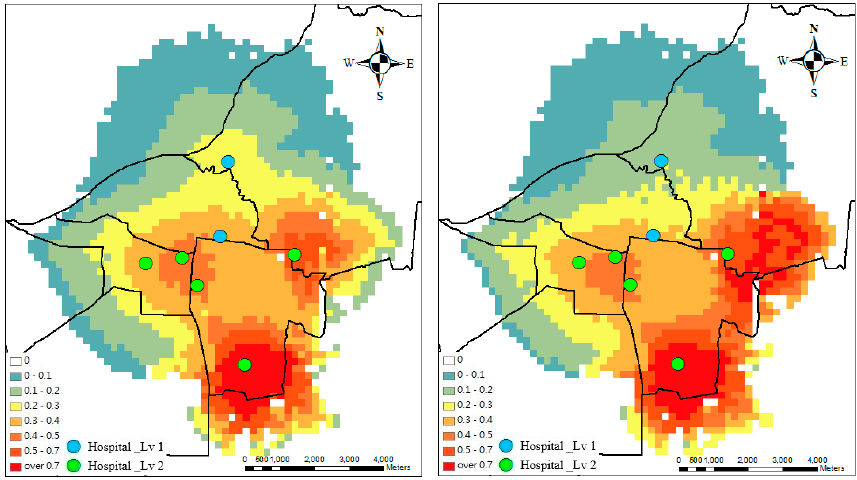
Figure 3. Accessibility without ( left ) and with ( right ) capacity at week 1.